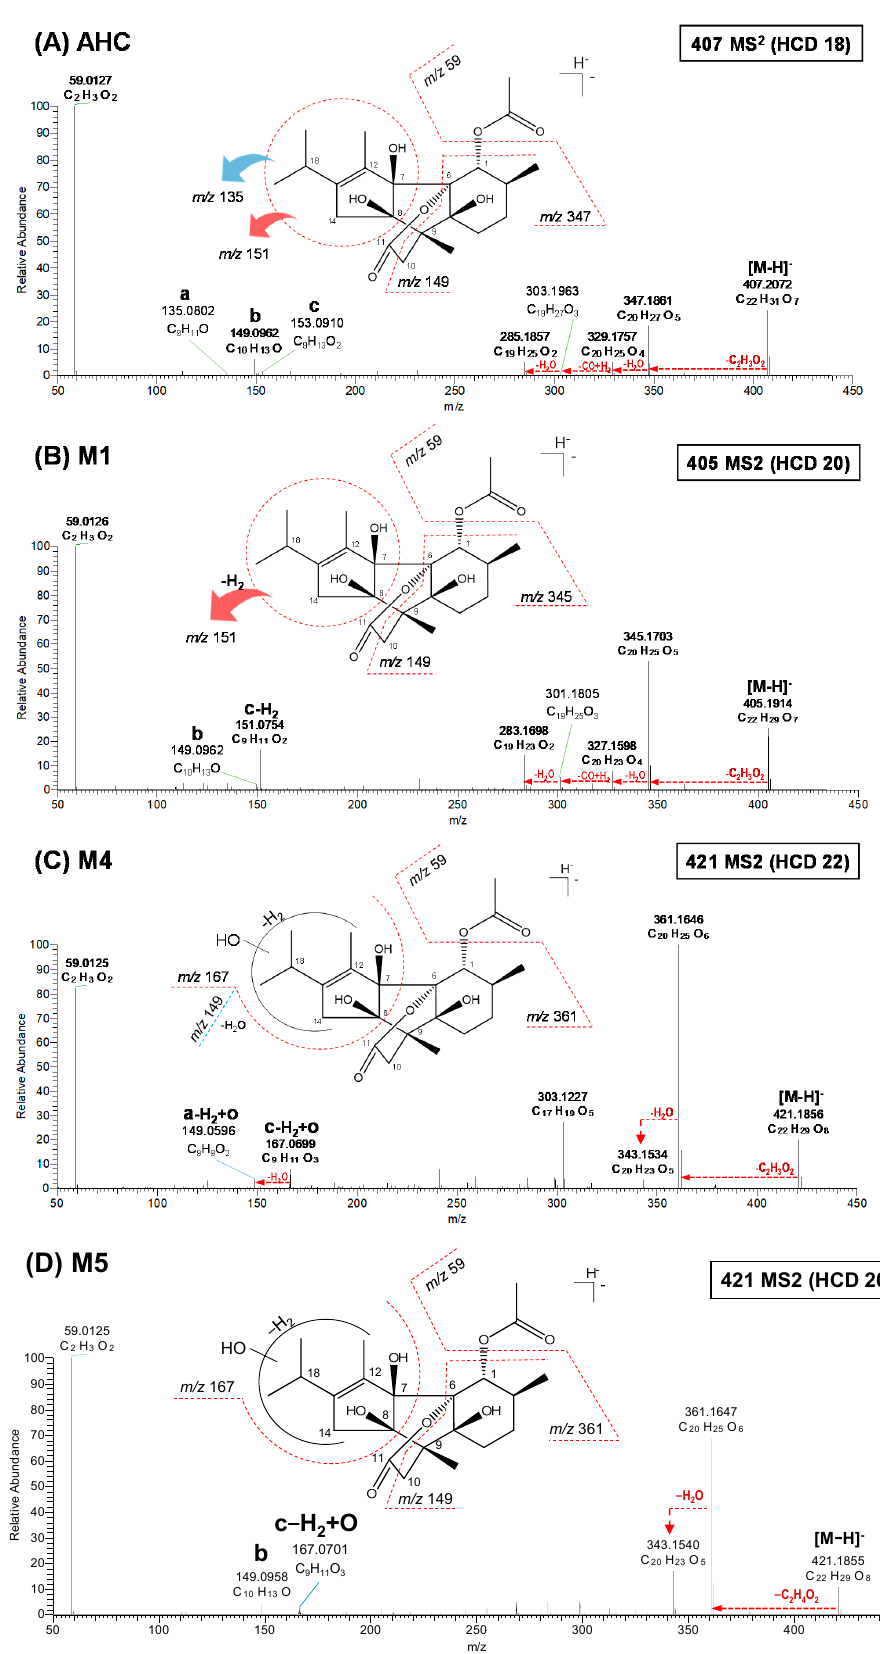
Figure 3. MS/MS spectra of deprotonated anhydrocinnzeylanine (AHC) ( A ), M1 ( B ), M4 ( C ), and M5 ( D ), obtained using a high-resolution quadrupole-orbitrap mass spectrometer (continued). HCD, higher-energy C-trap dissociation.